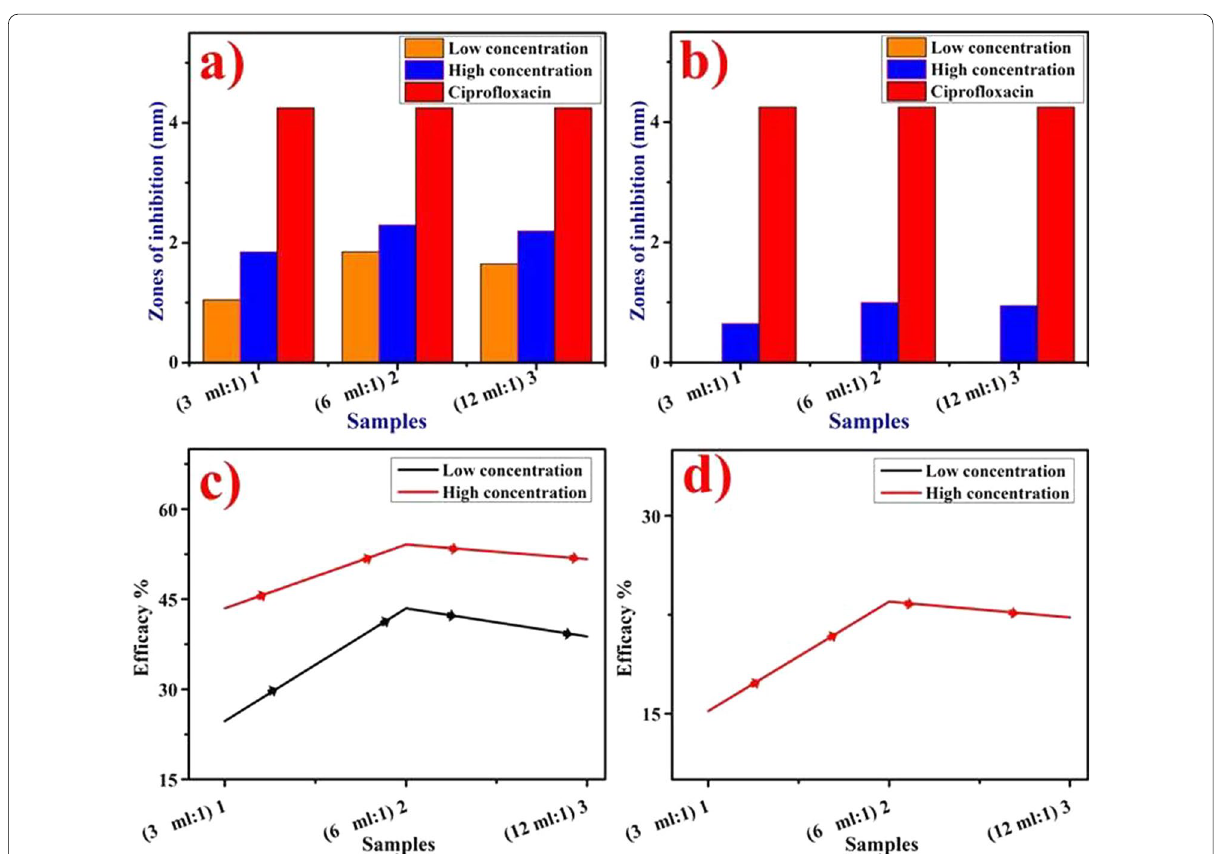
Fig. 9 a – d In vitro antibacterial activity of CuO NPs a doped with ZO at %age doped with ZO and d efficacy %age doped with AS